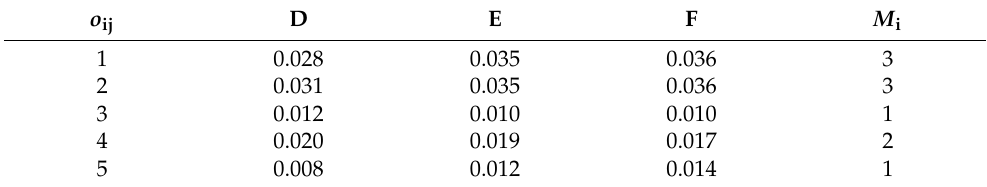
Table 2. Processing times (in